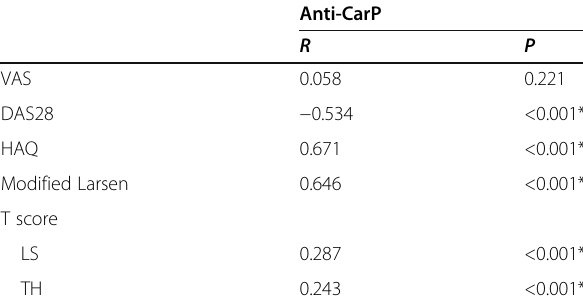
Table 5 Correlation between anti-CarP antibodies with clinical and radiological findings: It showed significant negative correlation with DAS28 and positive correlation with other parameters as performed by multiple logistic regression